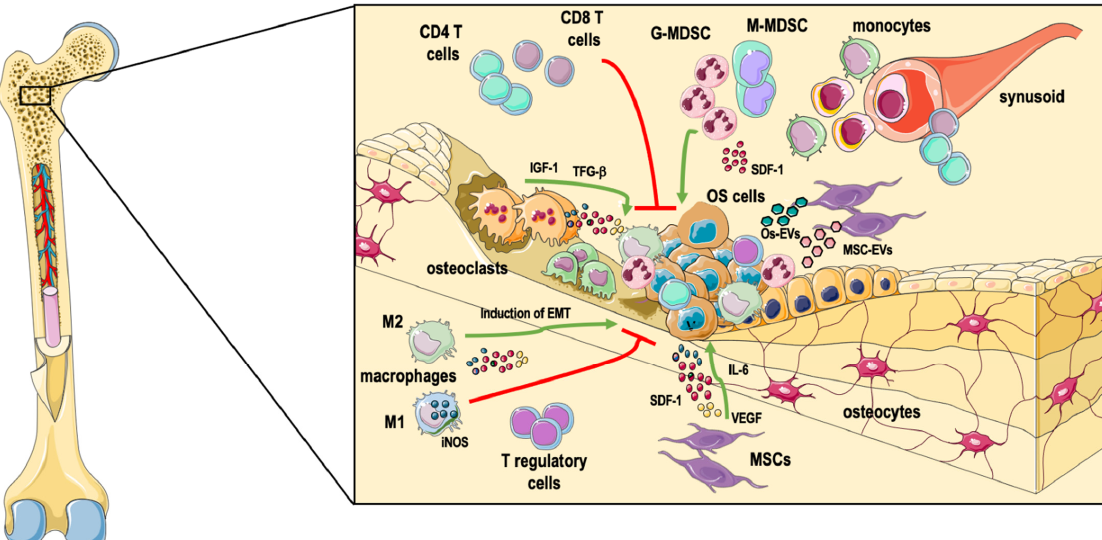
Figure 1. The complex osteosarcoma microenvironment in the bone tissue. Osteosarcoma (OS) develops in the highly specialized bone marrow (BM) environment, a highly dynamic tissue composed of bone cells, immune cells, and stromal and vascular cells, embedded in a mineralized extracellular matrix. The different cell types are reciprocally regulated, with OS cells producing factors that recruit and re-program immune, stromal, and bone cells to their advantage, and vice versa, with immune cells, osteoclasts, and stromal cells releasing pro-tumoral molecules such as VEGF (vascular endothelial growth factor), TGF β (transforming growth factor beta), and IL-6 (interleukin-6). The cross-talk between OS cells and other BM cells may also occur through the release of extracellular vesicles (EVs). OS cells, osteosarcoma cells; MSCs, mesenchymal stem cells; EMT, epithelial-to-mesenchymal transition; G-MDSC, granulocytic myeloid-derived suppressor cells; M-MDSC, monocytic myeloid-derived suppressor cells. Red line: negative signal; green arrow: positive